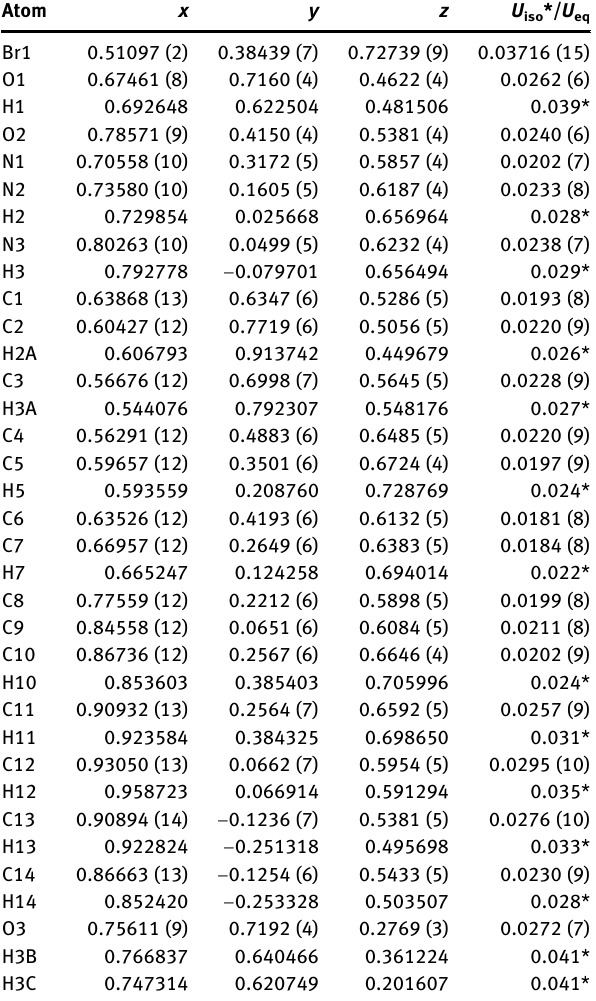
Table  : Fractional atomic coordinates and isotropic or equivalent isotropic displacement parameters (Å 